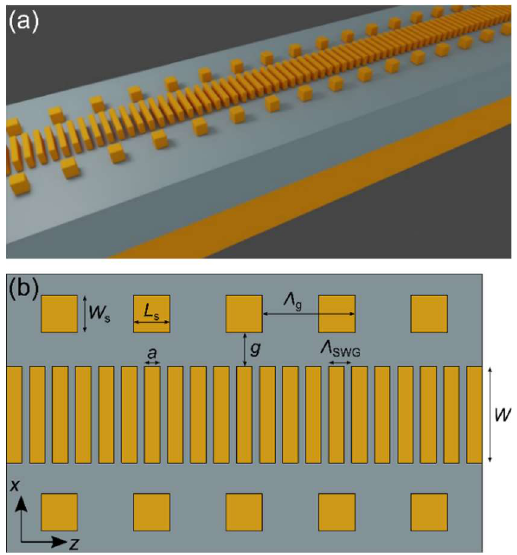
Fig. 2. Schematic (a) 3D view and (b) top view of a millimetre- long optical antenna with SWG waveguide core and evanescently coupled loading